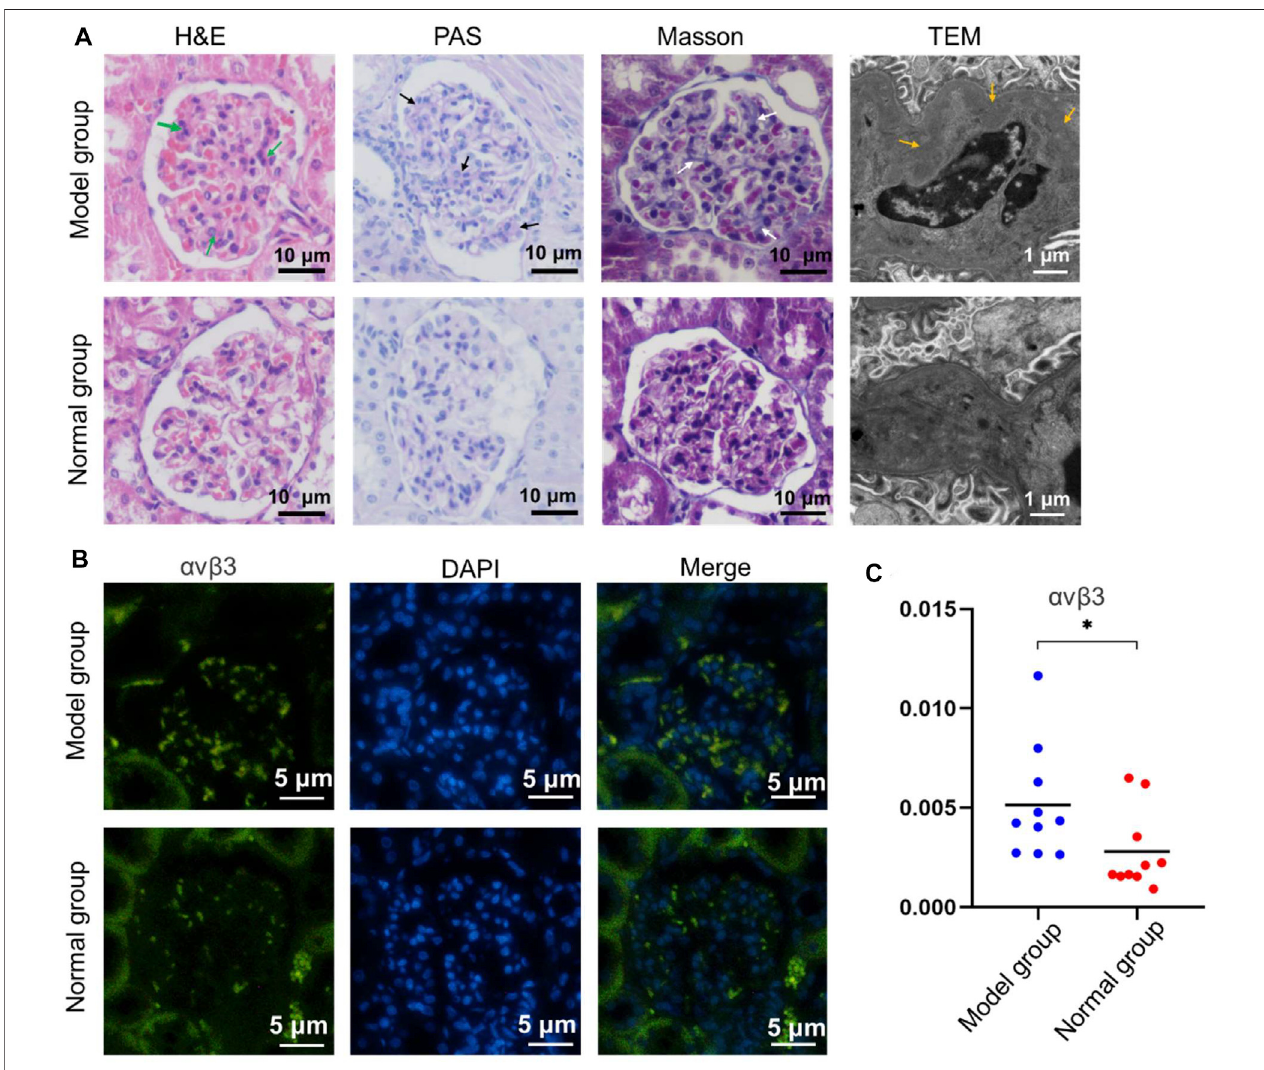
FIGURE3| Pathological stainingofrenal tissue inthemodel group and normal group. (A) The H&Estaining, PASstaining, Massonstaining,and TEM investigation werestudied,respectively. (B) α v β 3Immuno fl uorescenceofrenaltissuewithdifferenttreatment. (C) Thecorrespondingquantitativeanalysisoftheexpressed α v β 3in(b) (* p <